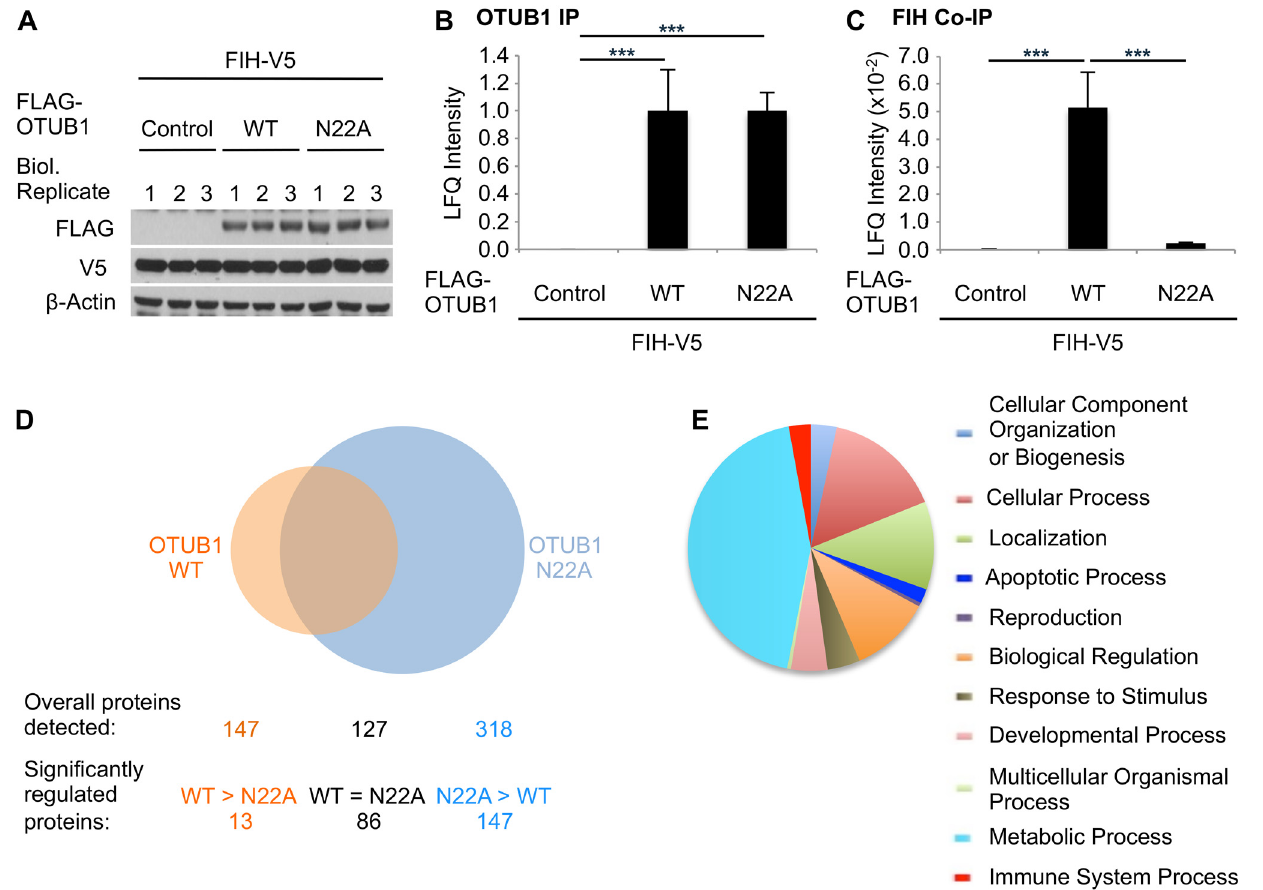
Fig 4. Point mutation of asparagine 22 to alanine regulates the OTUB1 interactome. HEK293 cells were transfected in biological triplicates with pFIH-V5 and empty vector (control), pFLAG-OTUB1 WT, or pFLAG-OTUB1 N22A for 24 h. Following FLAG immunoprecipitation, the precipitates were analyzed for OTUB1-associated proteins by mass spectrometry. (A) Western blot analysis of overexpression levels of OTUB1 WT and N22A. (B) Relative amount of immunoprecipitated OTUB1 in each sample. (C) Relative amount of FIH co-precipitated with OTUB1 in each sample (normalized to precipitated OTUB1 levels). (D) Number of interacting proteins enriched in FLAG-OTUB1 WT or N22A over control. “ Significantly regulated proteins ” indicates the number of proteins being significantly different between FLAG-OTUB1 WT and N22A as indicated. Peptide sequences that were assigned to several proteins were counted as a single interaction. (E) Gene Ontology analysis for biological processes of proteins significantly enriched and increased by at least 2-fold in FLAG-OTUB1 N22A over FLAG-OTUB1 WT. The experiment was performed with three biological replicates and two technical replicates per sample. (B), (C) Data presented as mean + SD. *** p < 0.001 by Student ’ s t test. (D), (E) The analyses were performed using Panther database